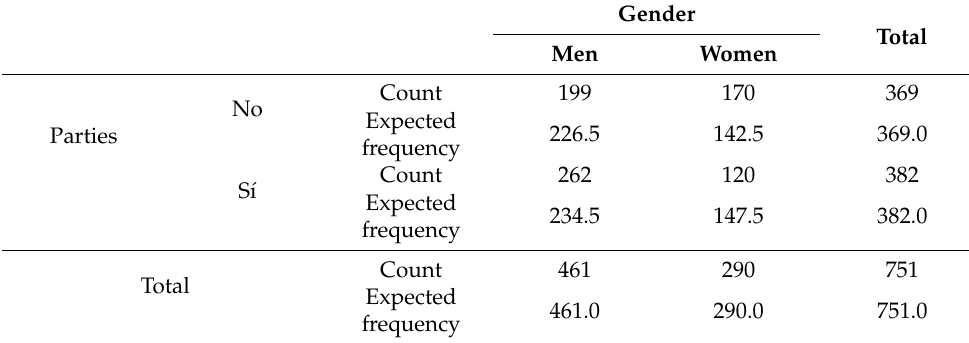
Table A1. Contingence table (Item: Gender).